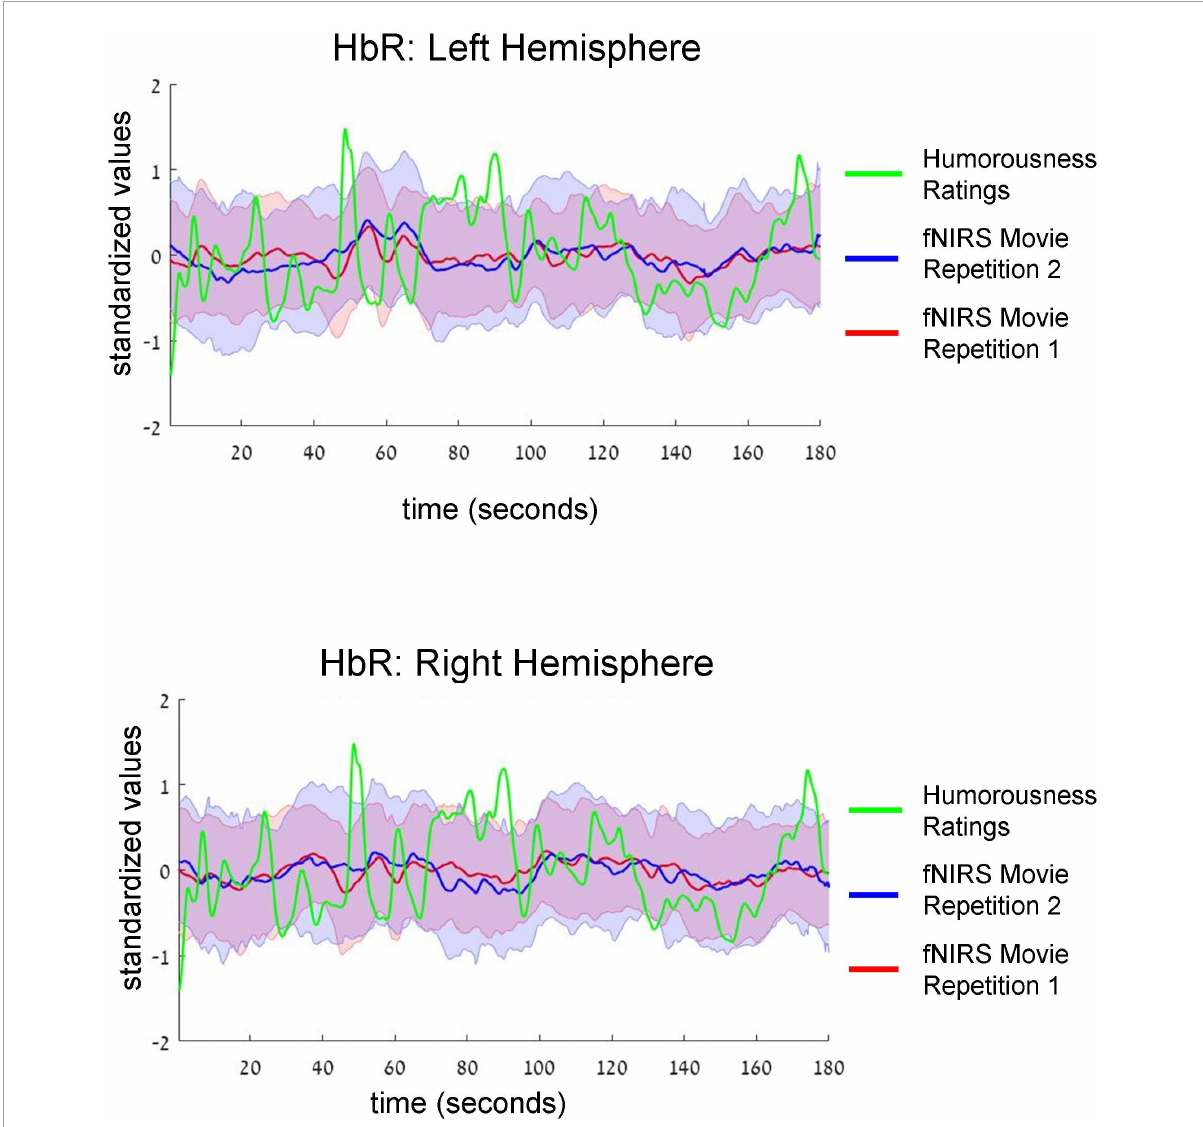
FIGURE4 Group-average time-courses of HbR fNIRS neural data (i.e., two movie repetitions) and the ratings of humorousness of an independent group of participants. The same convention as in Figure 3 is used. There was no correlation between neural signals and ratings of